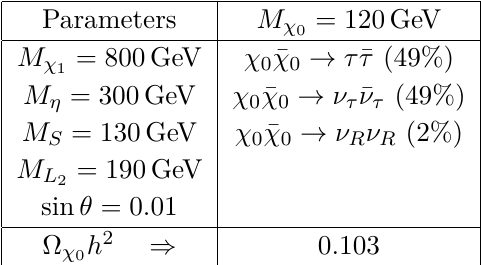
Figure 16 . (a) Variation of Relic density as a function of DM mass M χ Allowed paramter space projected over the relic density